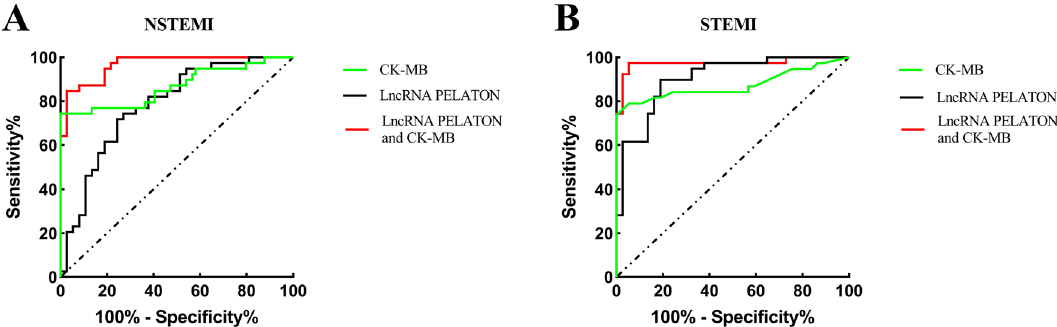
Figure 4. Evaluating ACS by lncRNA PELATON and CK-MB. ( A ) ROC curve for evaluating NSTEMI; ( B ) ROC curve for evaluating STEMI.